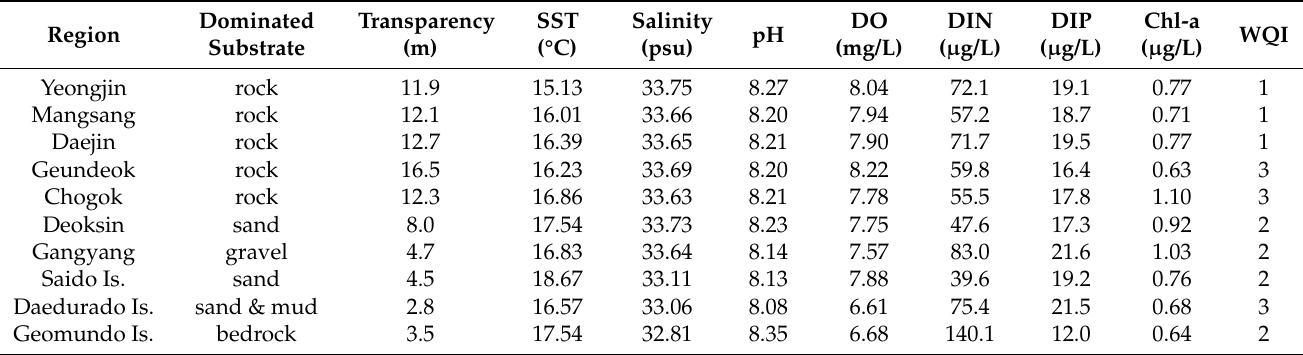
Table 2. Marine environmental data at the study